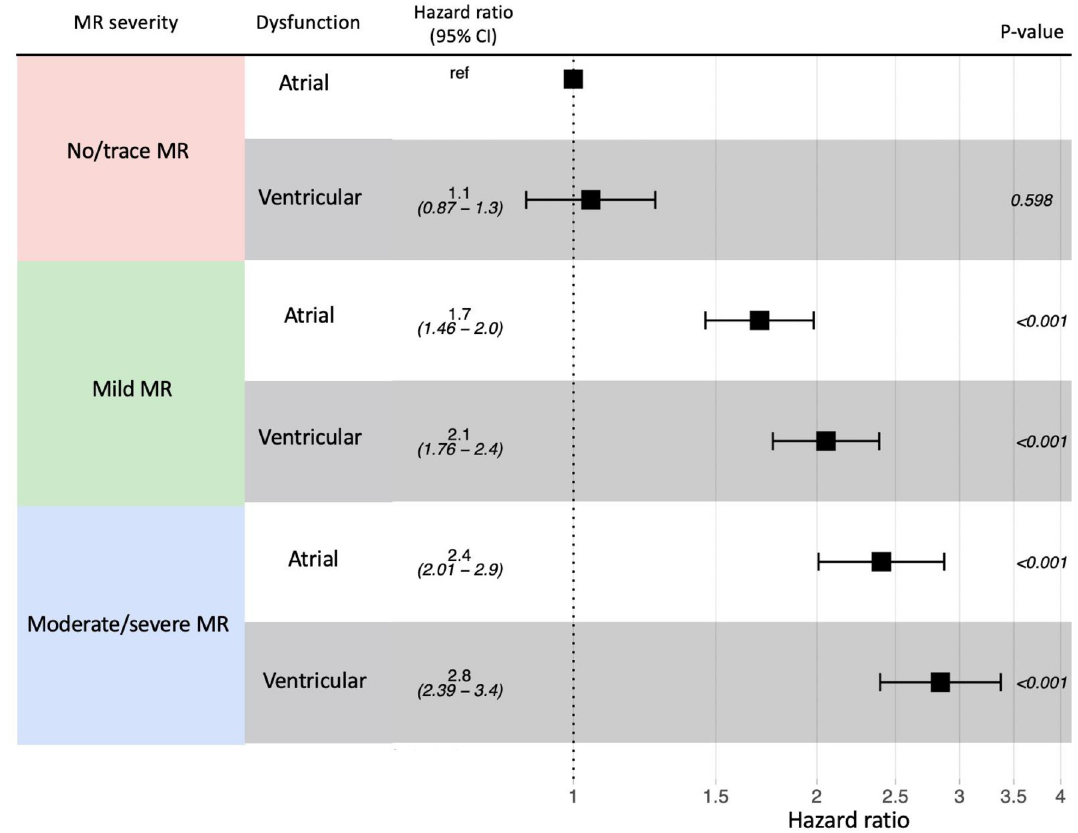
Fig 4. Hazard of death associated with MR severity and atrial or ventricular dysfunction in matched group. The figure shows increasing hazard of death with increasing mitral regurgitation (MR) severity. Within the same MR severity, ventricular